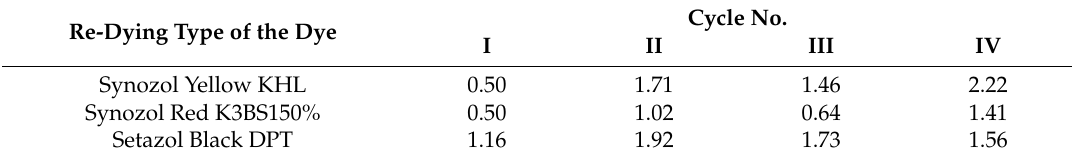
Table 2. DE CMC values in accordance to ISO 105-J03, when depth of shade was 1% (w/w). Re-Dying Type of the Dye Cycle No.